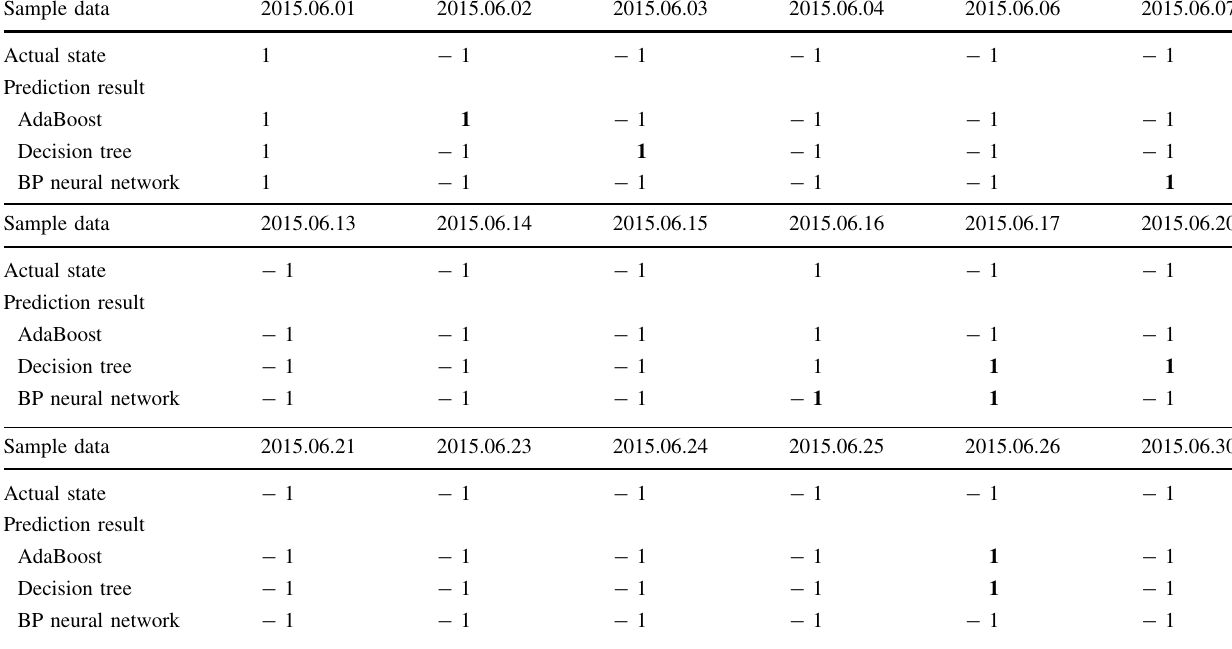
Table 7 Fault prediction results on the test set Sample